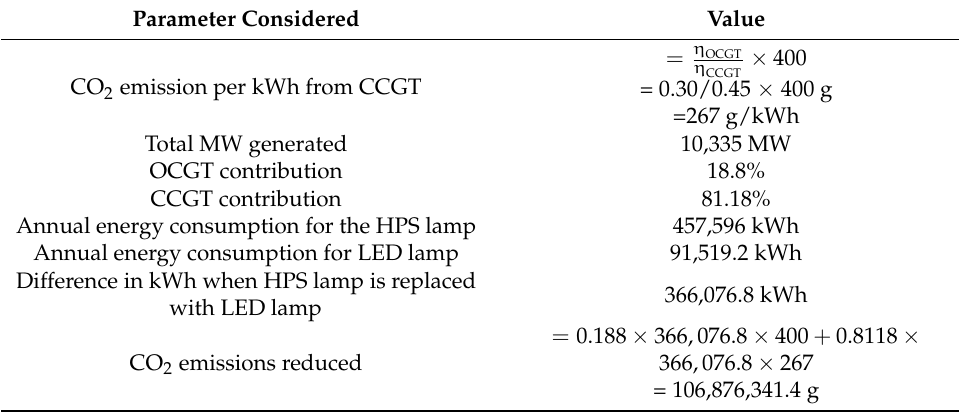
Table 6. Estimation of CO 2 emission